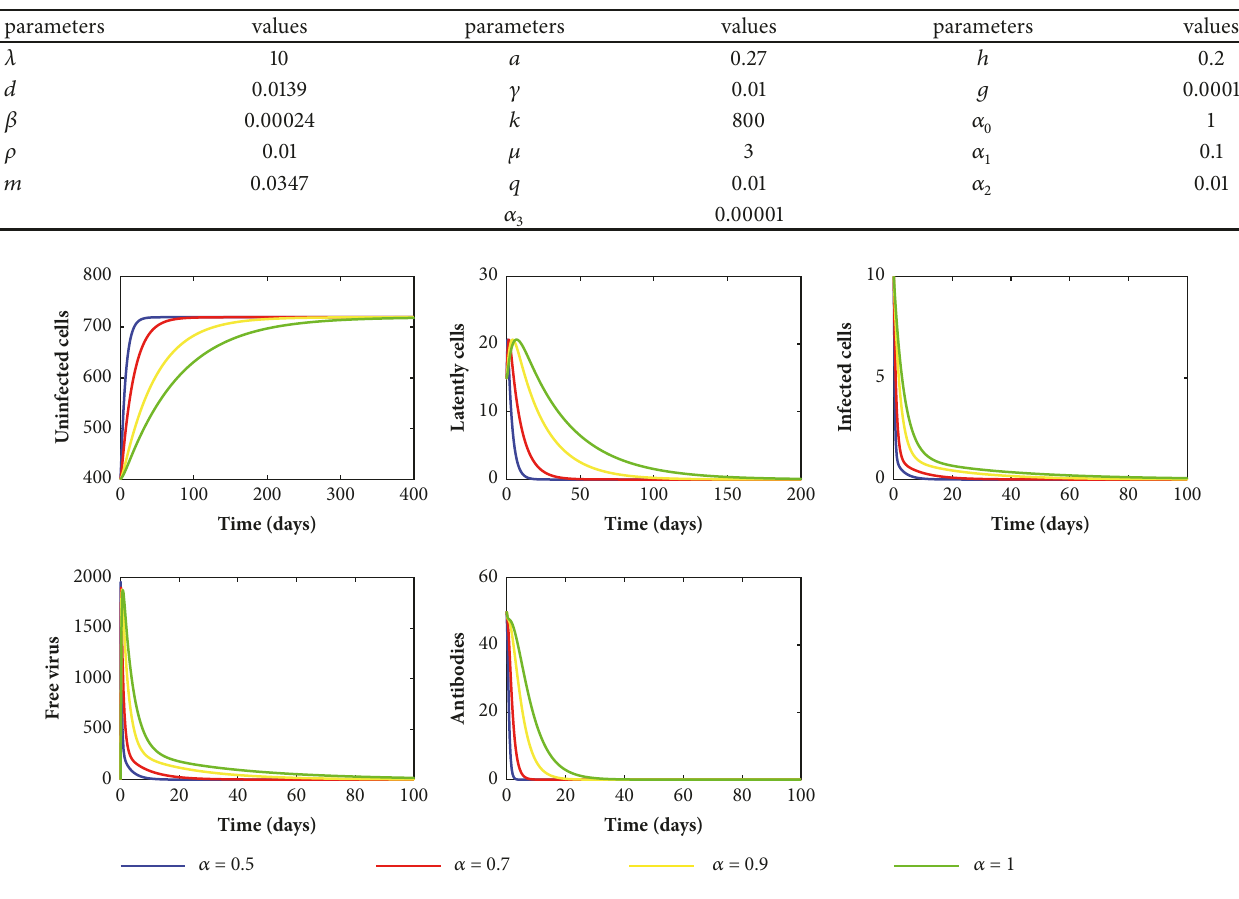
Figure 1: Stability of the infection-free equilibrium 𝐸 0 .